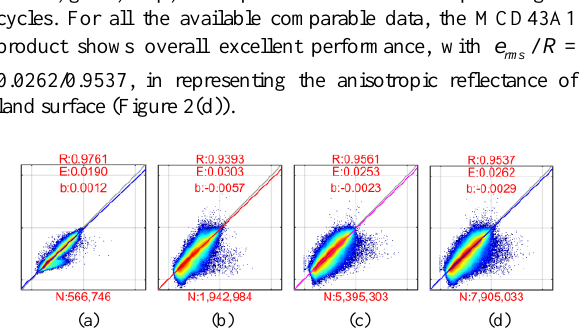
Figure 2. Overall accuracy of MCD43A1 model.